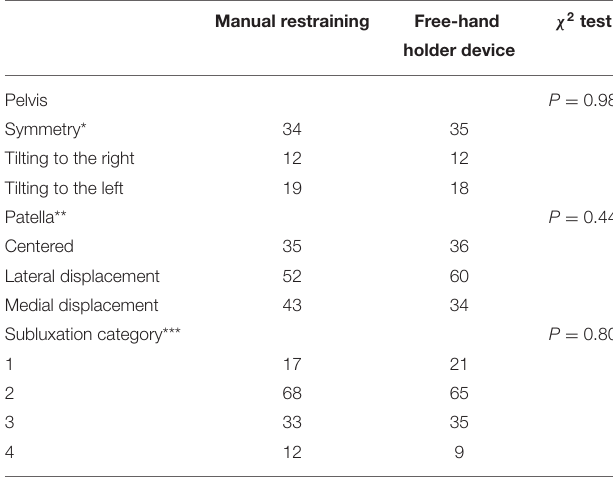
TABLE 1 | Pelvic tilting, patella displacement, and subluxation categories in manual-restraining and hands-free holder device. Manual